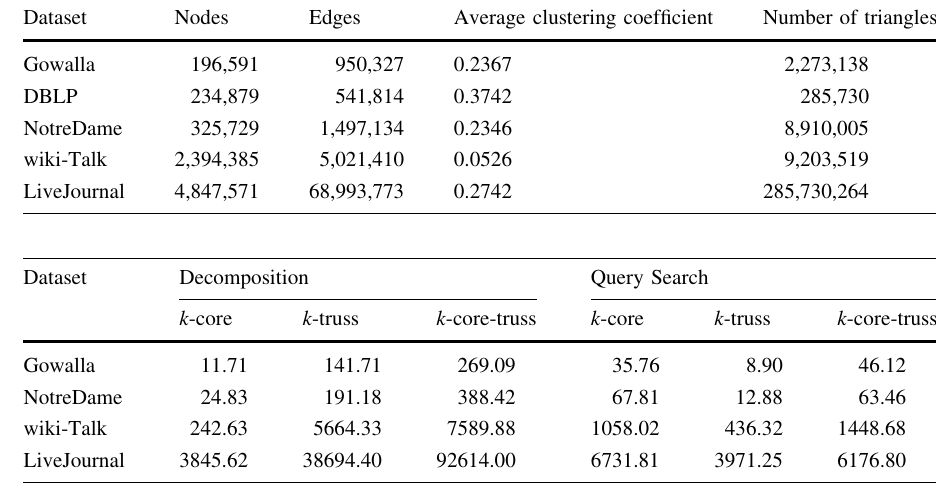
Table 2 Datasets